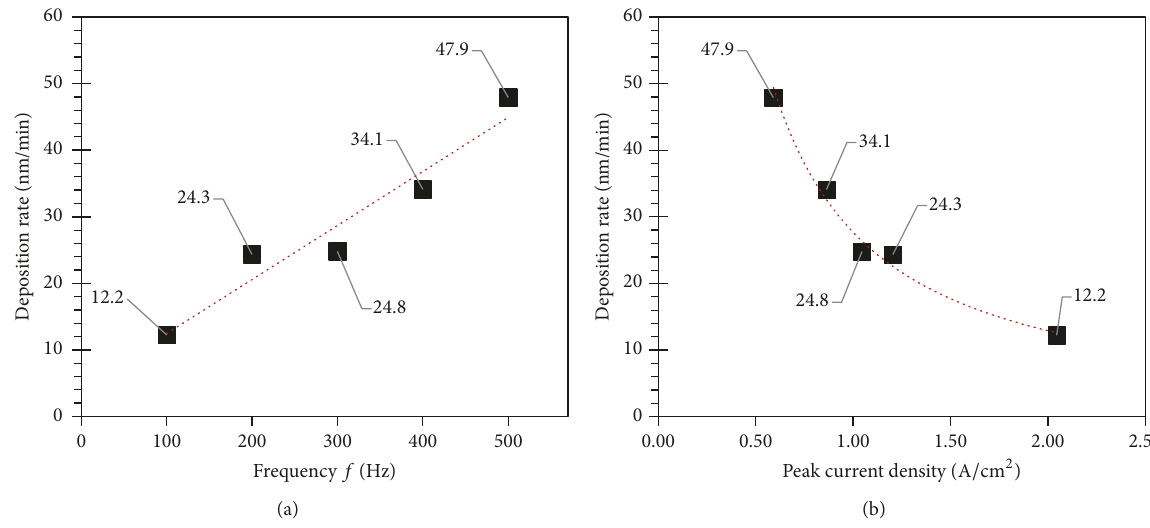
Figure 3: Deposition rate of the AlTiN coatings depending on pulse-frequency (a) and on the resulting peak current density (b) at different pulse-frequencies in the range of 100–500Hz with a constant pulse length of 50 𝜇 s and deposition time of 30 minutes.